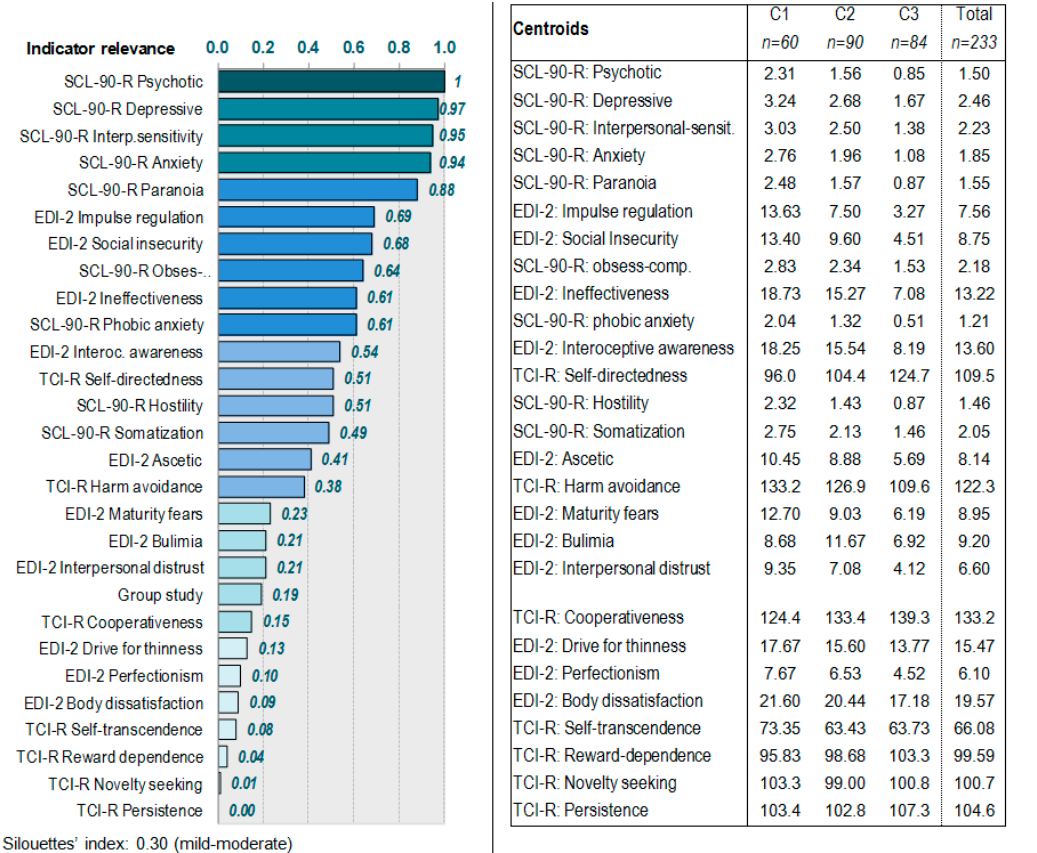
Figure 1. Results of the clustering procedure. Note. EDI-2: Eating disorders Inventory 2. SCL-90-R: Symptom Checklist-90-Revised. SCL-90-R Obsess-comp.: Obsession-Compulsion SCL-90-R subscale. TCI-R: Temperament and Character